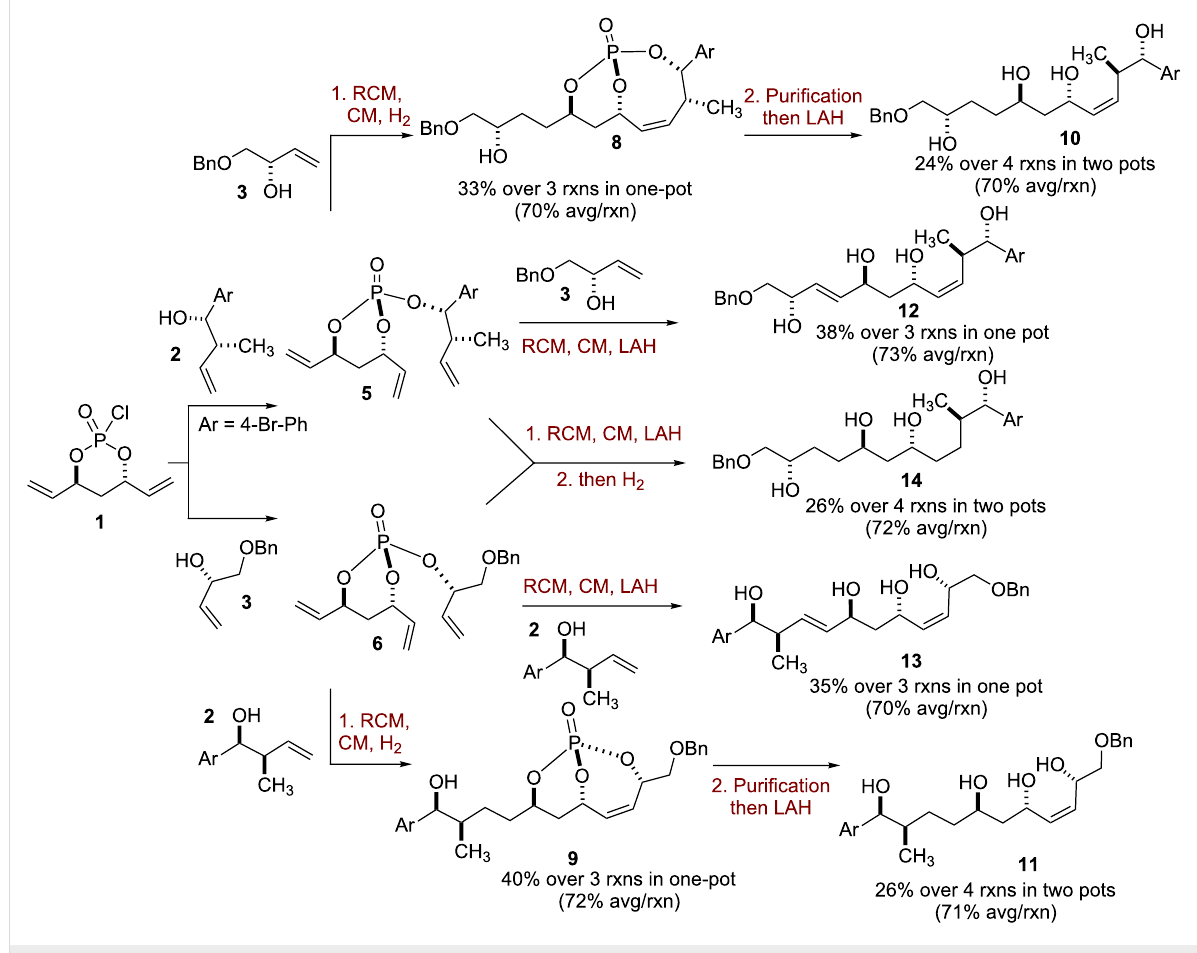
Scheme 2: Synthesis of polyols 10 – 14 in one-, two-pot sequential protocols.